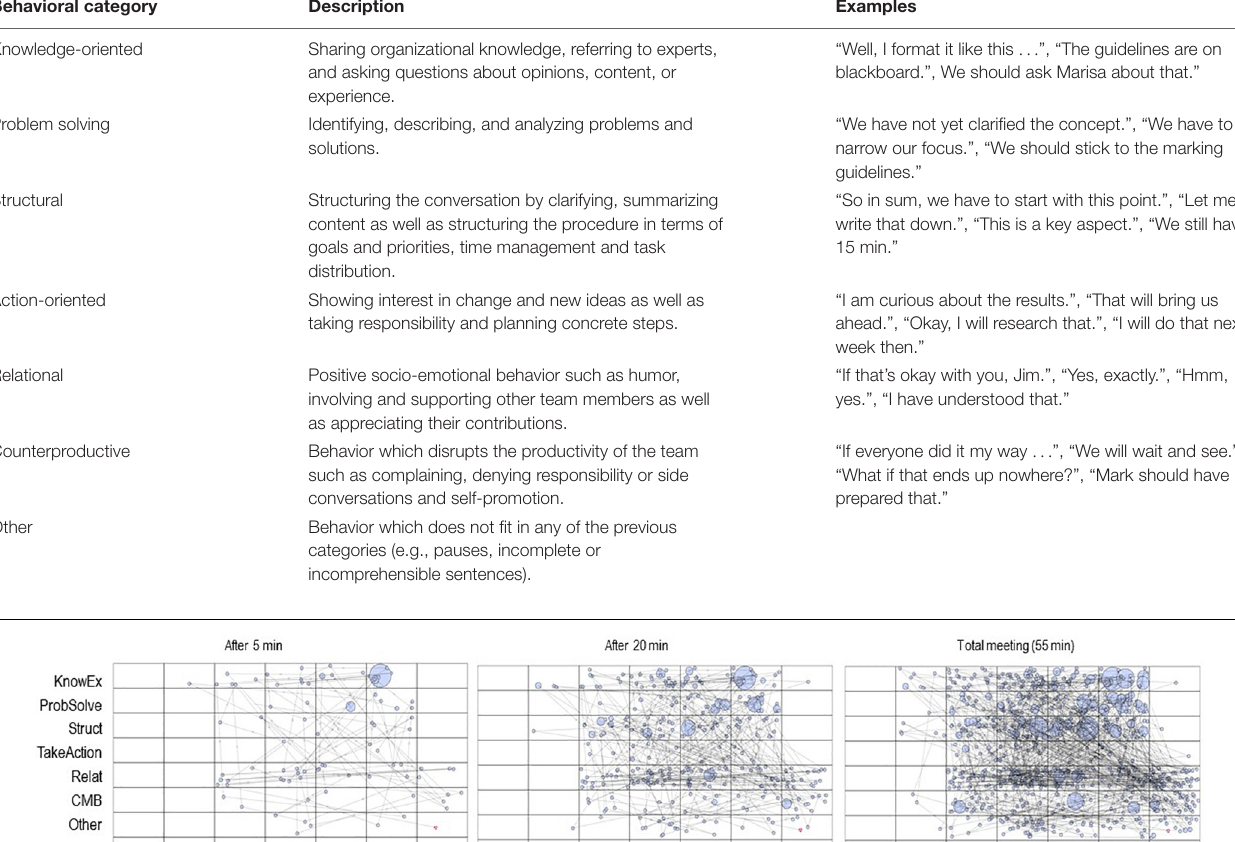
TABLE 3 | Behavioral categories, descriptions, and sample statements.